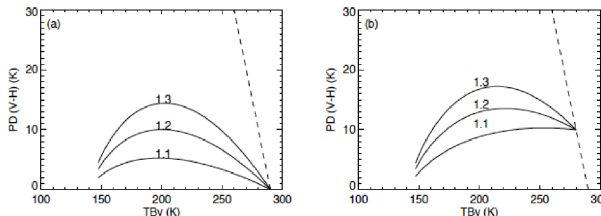
Figure 7. PD–TB V relationships from Eqs. (1) to (2) for differ- ent aspect ratios (ARs, value marked above each curve), assuming that the background emission is unpolarized (left, T (cid:48) and polarized (right, T (cid:48) a typically polarized surface emission from wind-induced surface